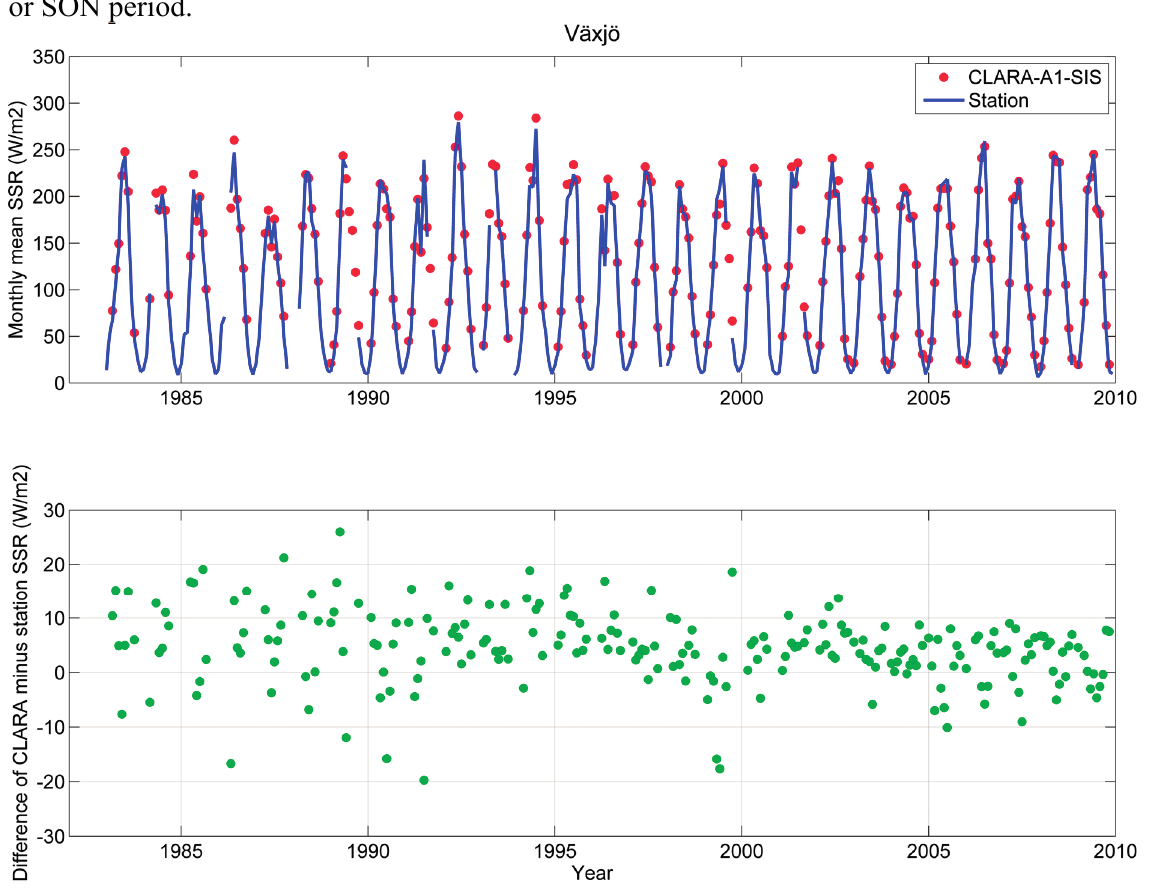
Figure 4. Comparison of retrieved monthly mean SSR by CLARA-A1-SIS against station observations at Växjö, Sweden. ( Upper panel ) station observations (blue line) versus CLARA-A1-SIS retrievals (red circle). All valid retrievals for either source shown. ( Lower panel ) Difference in the obtained monthly mean